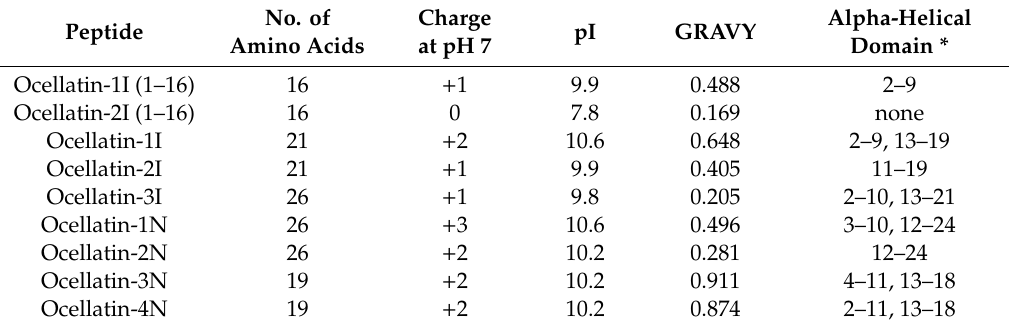
Table 1. Physicochemical properties of the ocellatin-related peptides isolated in this study from norepinephrine-stimulated skin secretions of L. insularum and L. nesiotus . Alpha-Helical No. of Charge pI GRAVY Peptide Domain Amino Acids at pH 7